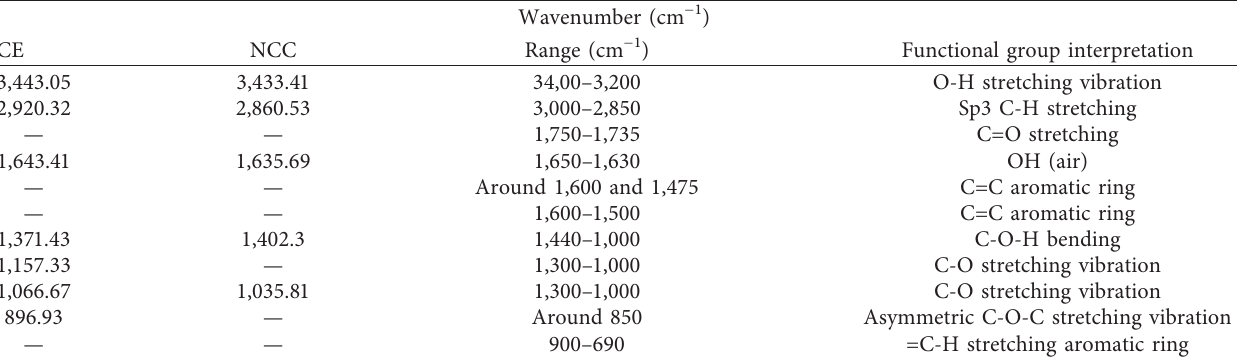
Table 2: Functional group analysis of the CE and NCC.